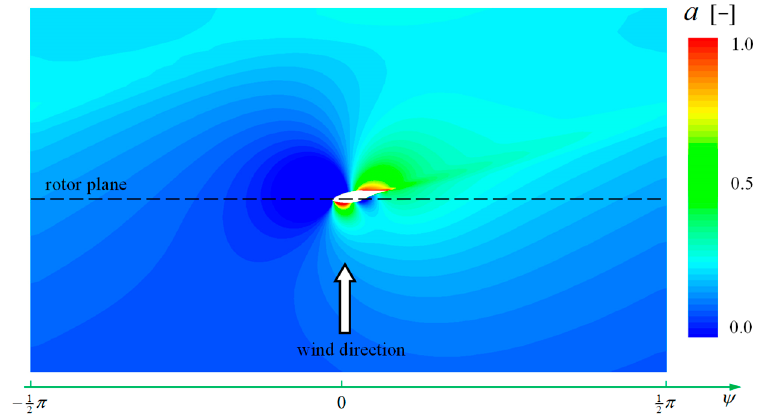
Figure 7. Contours of axial interference factor before self-induction subtraction in the flattened section of r / R = 47%, where ψ denotes the azimuthal angle ( V ∞ = 7m/s, ω = 72rpm).